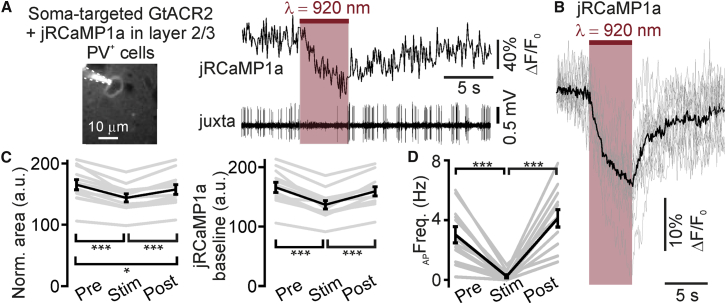
Simultaneous Two-Photon Imaging and Two-Photon Holographic Inhibition In Vivo(A) Left: image of a layer 2/3 PV+ interneuron co-expressing jRCaMP1a and the soma-targeted GtACR2 in vivo. The neuron was imaged and simultaneously recorded in the juxtasomal configuration. The patch pipette containing Alexa 594 is indicated by the dashed lines. Right: trace showing jRCaMP1a fluorescence (top, excitation wavelength: λ = 1,100 nm) and the spiking activity (bottom) for the neuron shown in (A). The cell was illuminated with a two-photon elliptical shape (red bar, λ = 920 nm; stimulation power: 50 mW; stimulus duration: 5 s).(B) Average decrease (ΔF/F0) (black trace) in jRCaMP1a fluorescence induced by holographic illumination at λ = 920 nm (pink bar) in cells co-expressing jRCaMP1a and the soma-targeted GtACR2. The gray traces represent single experiments. N = 12 cells from 3 mice. Imaging power range: 20–34 mW; stimulation power: 50 mW.(C) Area below the fluorescence trace (left) and fluorescence baseline level (middle) Pre, during (Stim), and Post holographic illumination (excitation wavelength: λ = 920 nm; stimulation power: 50 mW) in cells co-expressing jRCaMP1a and the soma-targeted GtACR2. Average area: p = 4E−7, ANOVA test with Bonferroni correction, N = 12 cells from 3 mice; average fluorescence: p = 1E−8, ANOVA test with Bonferroni correction, N = 12 from 3 mice.(D) Firing frequency of PV+ interneurons Pre, during (Stim), and Post holographic illumination. Excitation wavelength: λ = 920 nm; stimulation power: 50 mW; stimulus duration: 5 s. p = 8E−6, ANOVA test with Bonferroni correction, N = 12 stimulation trials from 3 neurons.In this figure, the black line represents the average and SEM, individual experiments are depicted in gray.